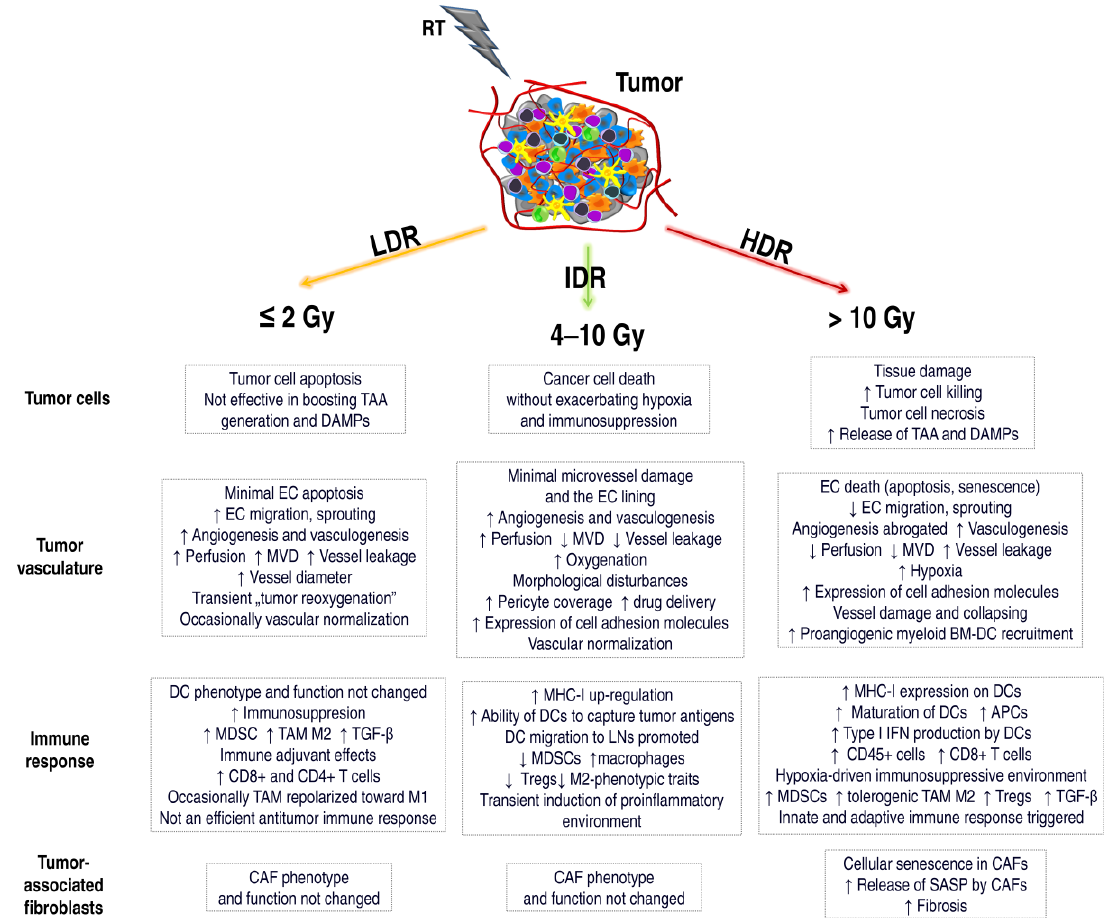
Figure 2. The effect of various doses of radiotherapy (RT) on the components of the tumor microenvironment. Radiation doses affect the cancer cells and the surrounding tumor microenvironment differently, including tumor vascularization, immune system cells, and CAFs. Low doses (Low-dose radiation, LDR) induce mainly apoptosis in cancer cells, with tolerogenic or immunogenic cell death. APCs are not activated, immunosuppressive macrophages TAM M2 and MDSCs are recruited. In some cases, TAMs may be polarized towards M1, and CD8+ and CD4+ T lymphocyte infiltration may be increased. However, the activated anticancer response is insufficient. ECs survive low IR doses, and angiogenesis/vasculogenesis is stimulated. During fractionated radiotherapy, “ tumor reoxygenation ” may occur, which leads to an increase in the effectiveness of RT. Intermediate-dose radiation (IDR) induces tumor cell death without increasing hypoxia or immunosuppression. MHC-I up-regulation, antigen presentation by DCs, reduced levels of MDSCs or Tregs, and transient induction of environmental proinflammatories occur. The vessels may be normalized, and perfusion, oxygenation, and the number of pericytes may be increased. IDR can also induce the process of angiogenesis or vasculogenesis. High-dose radiation (HDR) induces necrosis of tumor cells, and immunogenic cell death associated with the release of TAAs and DAMPs. An effective antitumor immune response is activated. ECs undergo apoptosis or senescence. Tumor vascularization is destroyed. Increased areas of hypoxia lead to an immunosuppressive environment. New vessels are formed in the process of vasculogenesis. CAFs also undergo a senescence process. They secrete a number of SASP factors involved in fibrosis and TME modulation. The effect of doses on tumor vascularization or immune system reactions is not entirely clear. There are conflicting literature reports. This is related to the fact that there is a delicate balance between the activation and inhibition of the immune system induced by RT. Further research into TME mechanisms triggered by various RT doses is necessary. TAA, tumor-associated antigens; DAMPs, death-associated molecular patterns; MVD, microvessel density; TGF- β , transforming growth